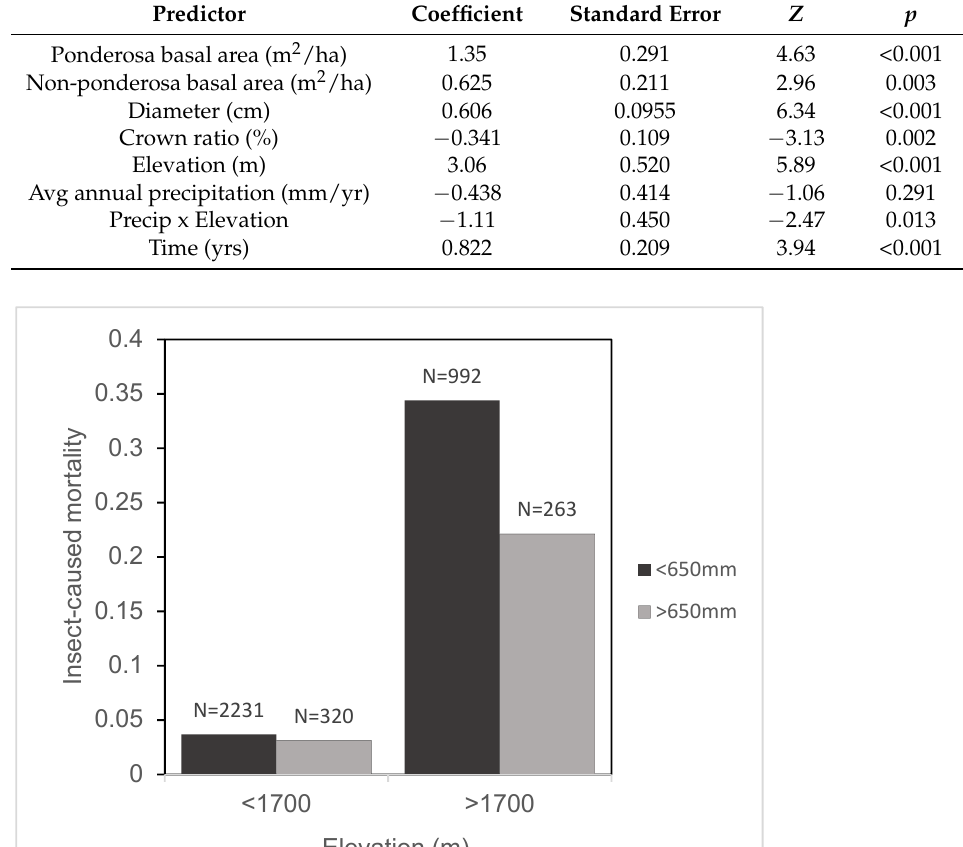
Figure 5. Regression lines derived from the final interaction model in Objective 3. The change in log odds of insect-caused mortality (relative to the mean value of elevation) is shown on the y -axis, controlled for the other components in the model. Data are split by average annual precipitation. In relatively dry stands, the risk of mortality rises quickly with elevation, but in relatively moist stands, the elevation-associated increase in mortality risk is less pronounced (precip × elevation, p = 0.0013).